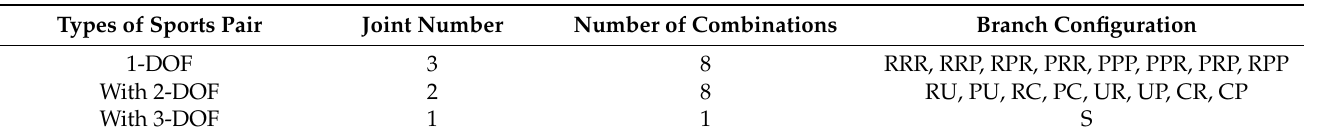
Table 1. Configuration combination of the auxiliary movement branch chain. (P-movement pair, R-rotation pair, U-Hooke’s hinge, C-Cylindrical pair, S-ball pair). Types of Sports